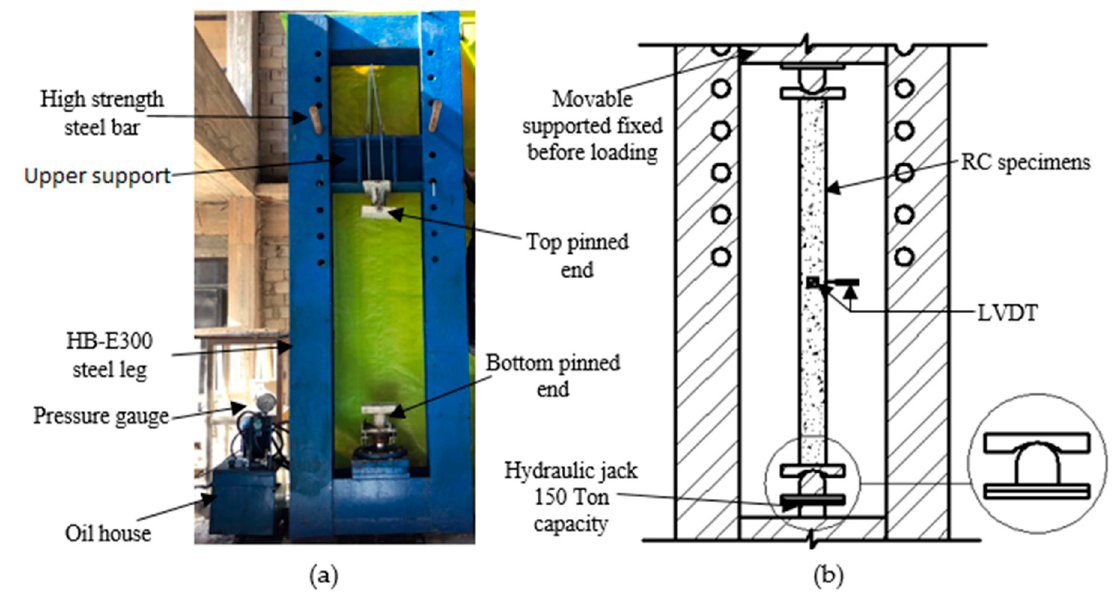
Figure 3. Loading frame, ( a ) in the laboratory, ( b ) detail of loading frame, two hinged support, and linear variable deflection transformer (LVDT) position.